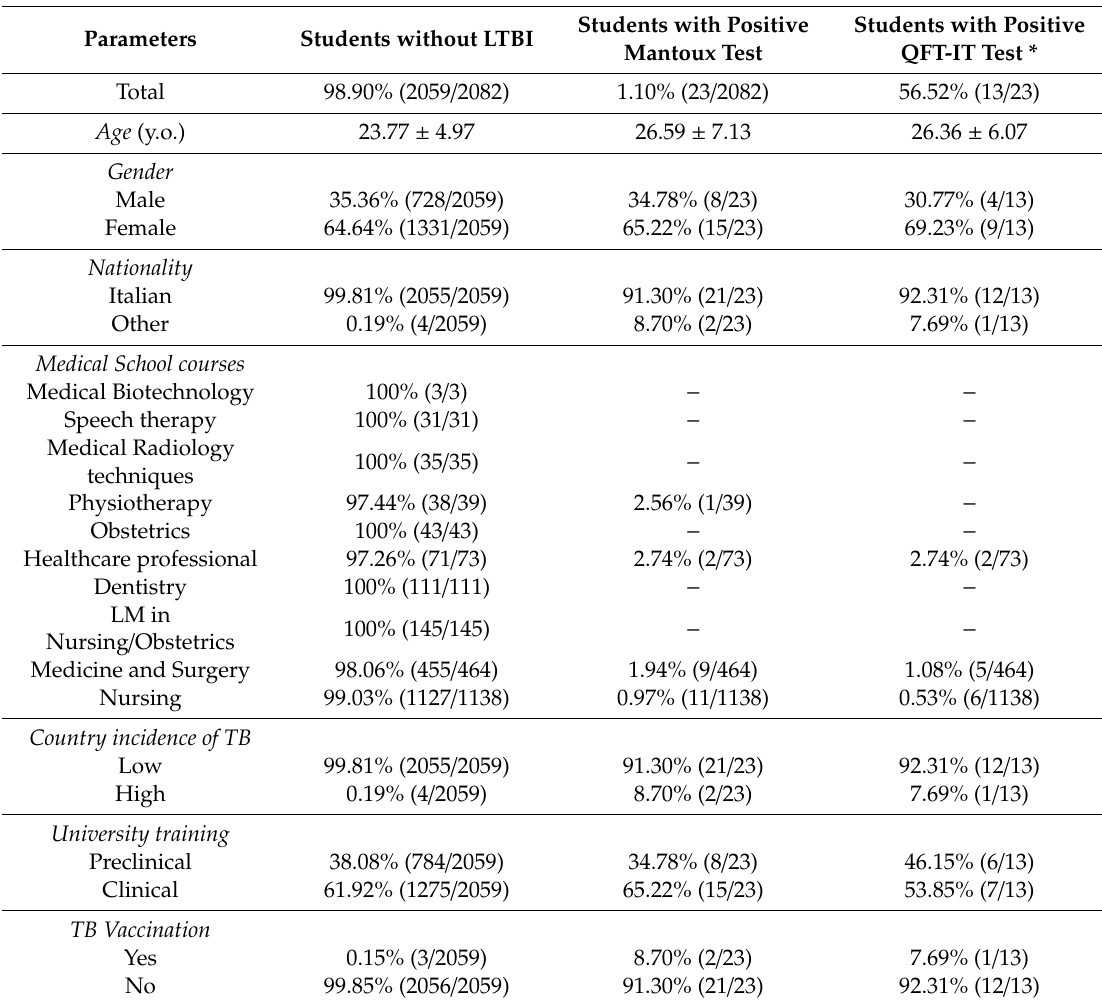
Table 1. Characteristics of 2082 medical school student (MSS) participants, stratified into medical school students with and without latent tuberculosis